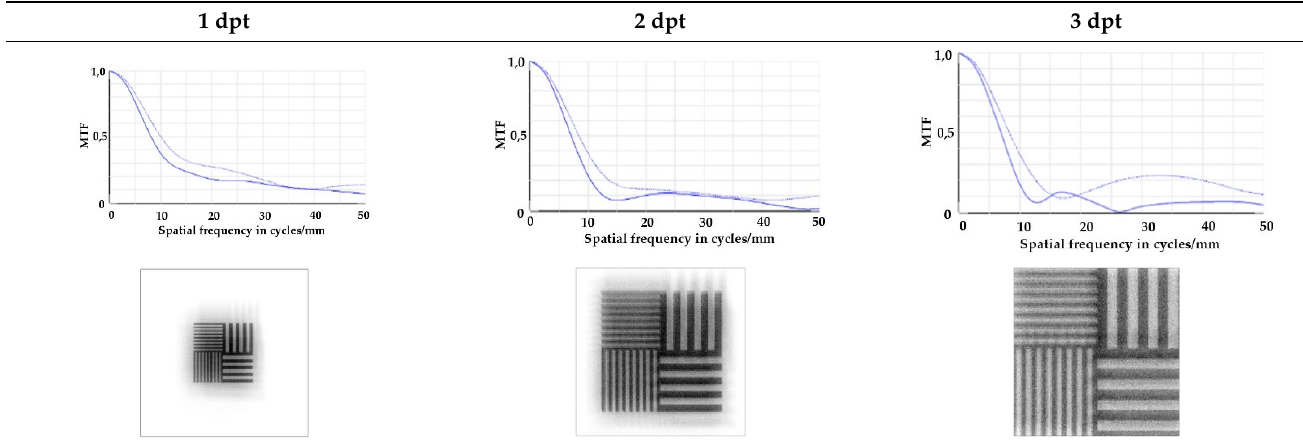
Table 2. Modulation transfer function (MTF) and geometric image analysis of three different adjustments of the rotation optics (1, 2, and 3 dpt) for the nominal surface constraint with a manufacturing tolerance of ±10 µm. 1 dpt